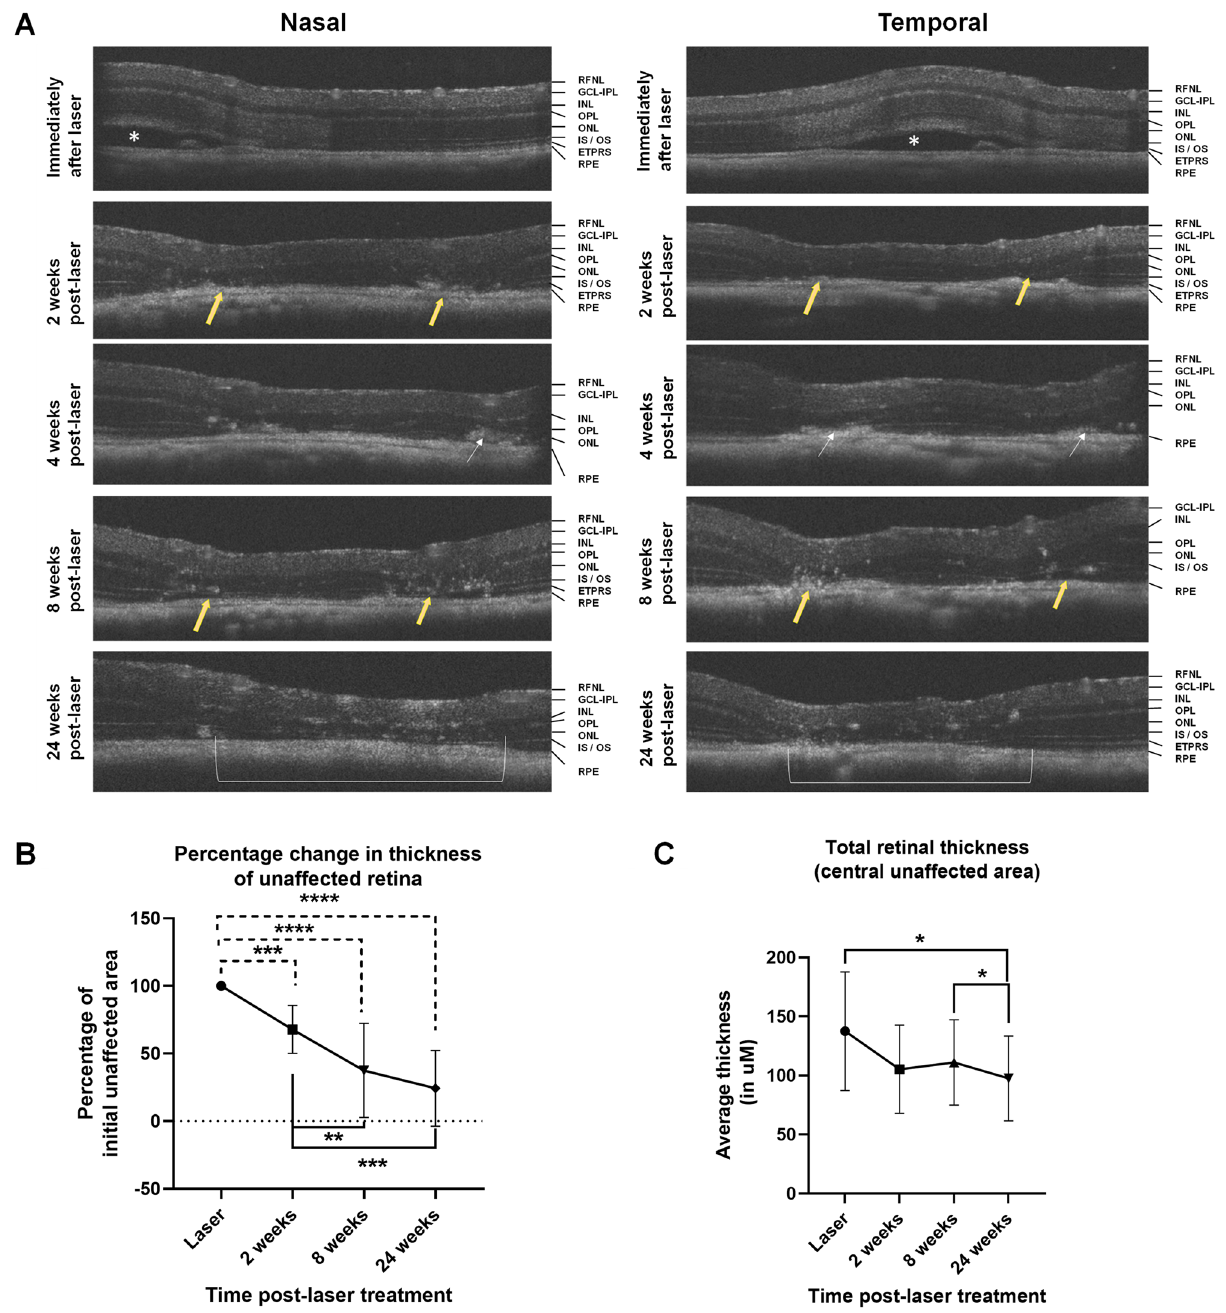
Figure 2. Laser-induced RLCS demonstrate optical coherence tomography (OCT) features characteristic of parafoveal GA progression. ( A ) Representative OCT scans from mouse eyes taken immediately after laser exposure, and at 2-, 4-, 8- and 24-weeks post laser treatment of C57/BL6J female mice to create a RLCS both nasal and temporal to the optic disc. Sub-retinal fluid accumulation immediately following laser treatment is shown (white asterisk), in addition to focal absence of the IS/OS junction at the laser spots (yellow arrow), ONL thinning, and development of hyperreflective areas (white arrow) and progression/merging of two atrophic spots to form a single lesion (white bracket) in lasered eyes. The data shown in the graphs represent the ( B ) mean percentage change in thickness of the central untreated retina, i.e. the percentage that remained unaffected and ( C ) total retinal thickness at the indicated time points post-laser treatment. Data are expressed as mean ± SD (n = 8 eyes per group from 8 different mice) and comparison of the indicated time points made to the time of laser using non-parametric Wilcoxon signed-rank testing.* p < 0.05, ** p < 0.01, *** p < 0.001, *** p < 0.0001. Retinal nerve fibre layer (RNFL), ganglion cell layer—inner plexiform layer (GCL-IPL), inner nuclear layer (INL), outer plexiform layer (OPL), outer nuclear layer (ONL), photoreceptor inner segment / outer segment junction (IS/OS), photoreceptor end tips (ETPRS) and retinal pigment epithelium